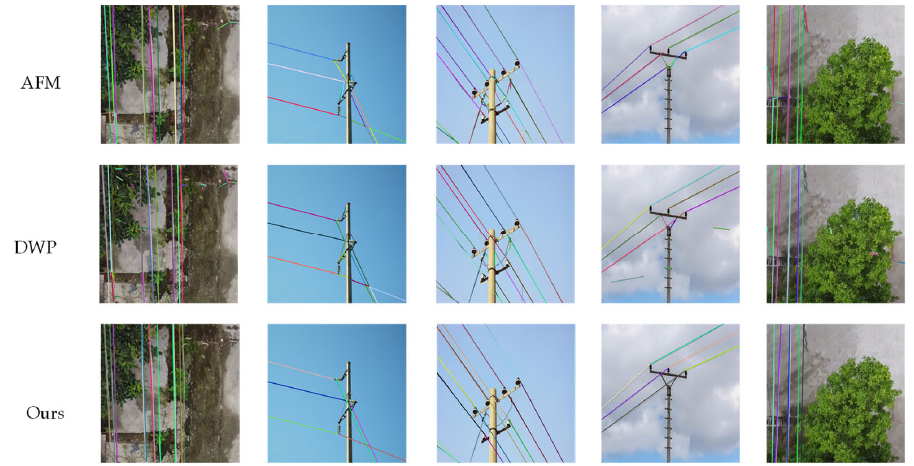
Figure 9. Comparison of the results of our model and the other two-line detector based on deep learning.